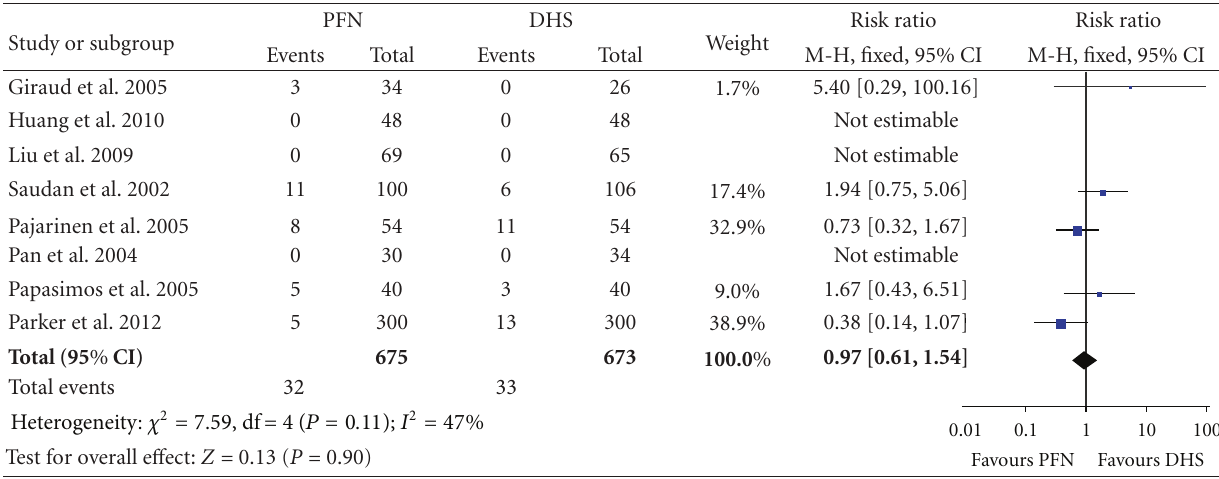
Figure 8: Comparison of reoperation between PFN and